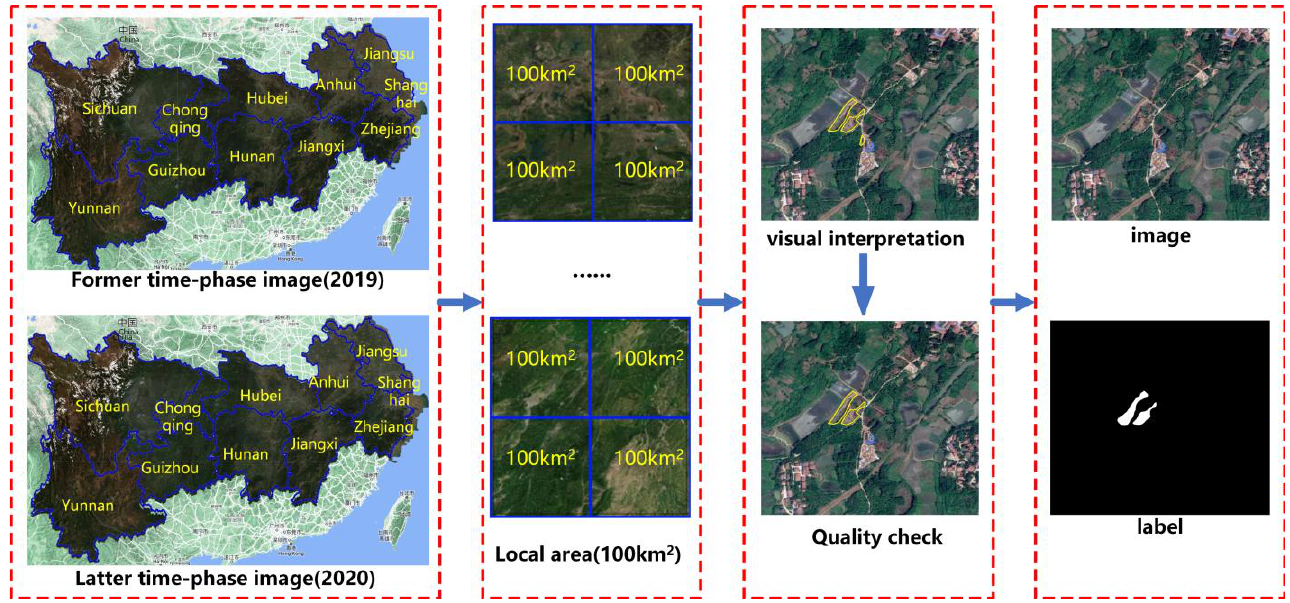
Figure 2. The flowchart of sample dataset generation.